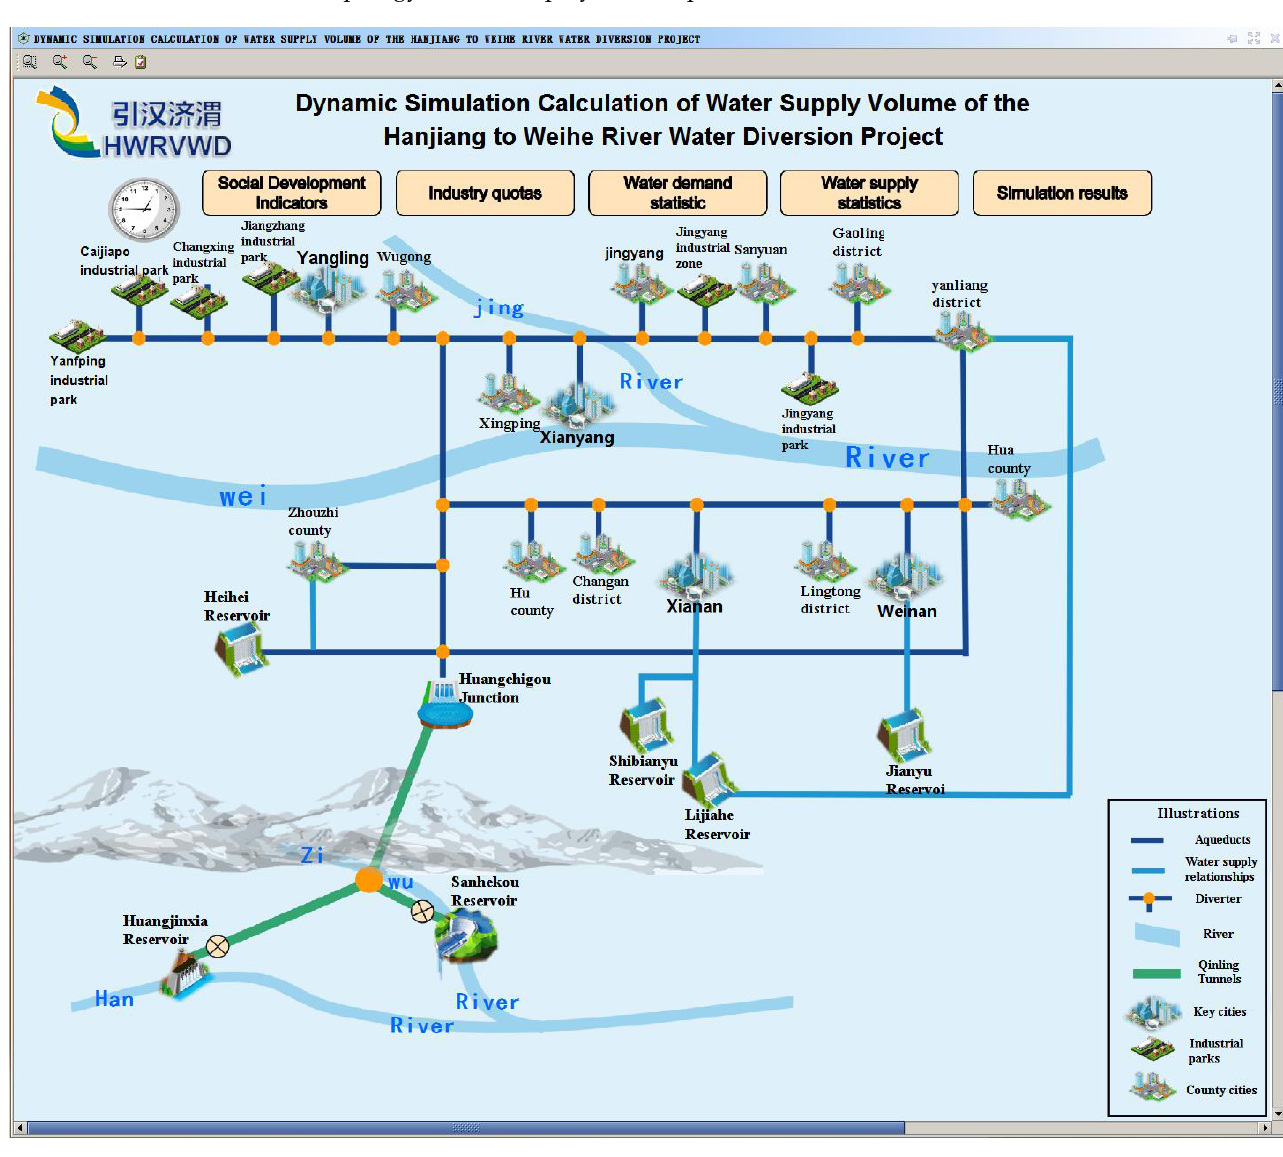
Figure 3. Topological structure (using topological theory to reduce engineering to a combination of point-line-surface structures) of Hanjiang-to-Weihe River Water Diversion (HWWD) Project. According to the simulation system’s construction principles and process, we con- structed the dynamic simulation system of water-supply volume for the HWWD Project. The computational-components net of the simulation system is shown in Figure 4. The simulation-calculation system gradually and visually presents the calculation process of water-supply volume. The decision-makers can click on any node in the calculation flowchart to check the calculation results, and the simulation system can calculate this node progressively. This computing paradigm makes the calculation process more clear and transparent, for example, by clicking the Huangjinxia Reservoir node and checking the calculation results of Huangjinxia